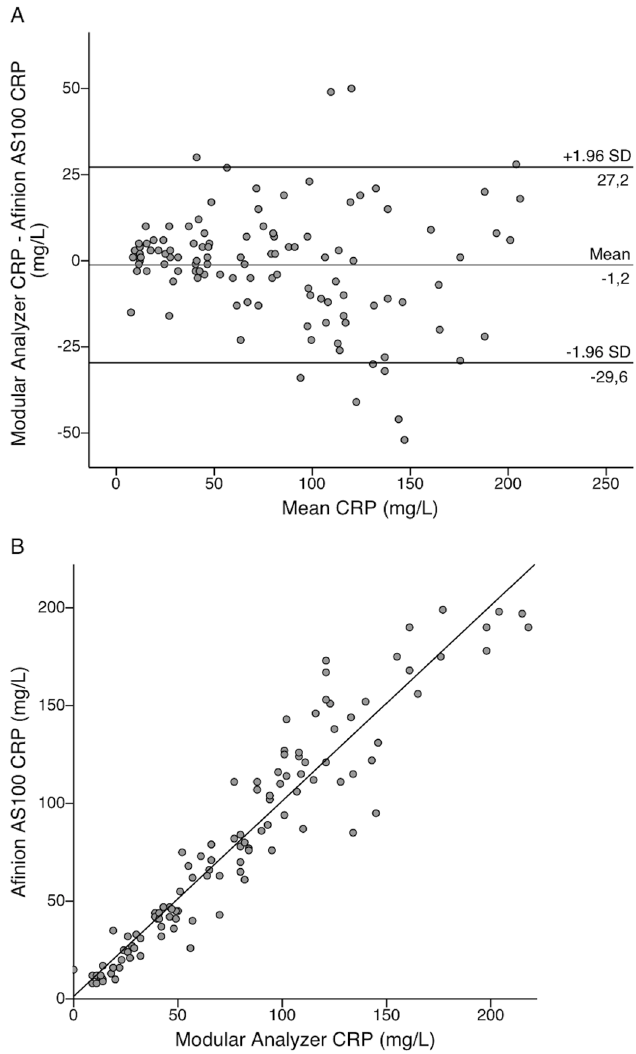
Fig 4. Bland-Altman and linear correlation plots for comparison of CRP methods in the emergency department. Bland-Altman plot presenting level of agreement (A) and a scatterplot showing linear correlation (B) between the Afinion AS100 C-reactive protein (CRP) point-of-care (POC) test and Modular CRP results in 171 pediatric emergency department (ED) visits. Clinicians performed POC testing at the ED in capillary blood samples and Modular CRP analysis was done in plasma separated from venous blood samples in the